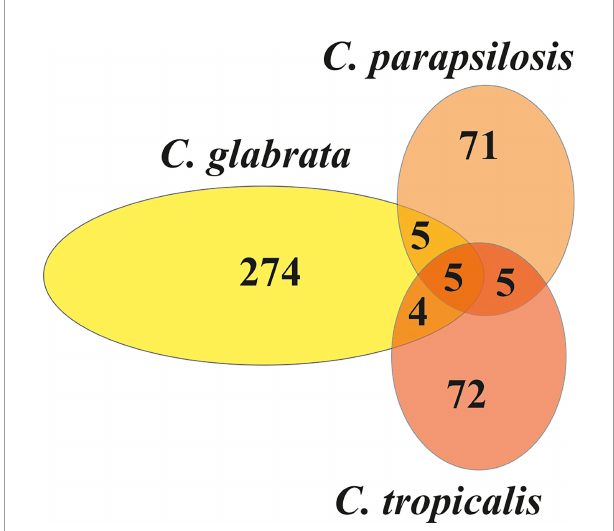
FIGURE 2 | The Venn diagram representing the numbers of individual and common proteins among EVs from C. glabrata , C. parapsilosis , and C. tropicalis bio fi lms.